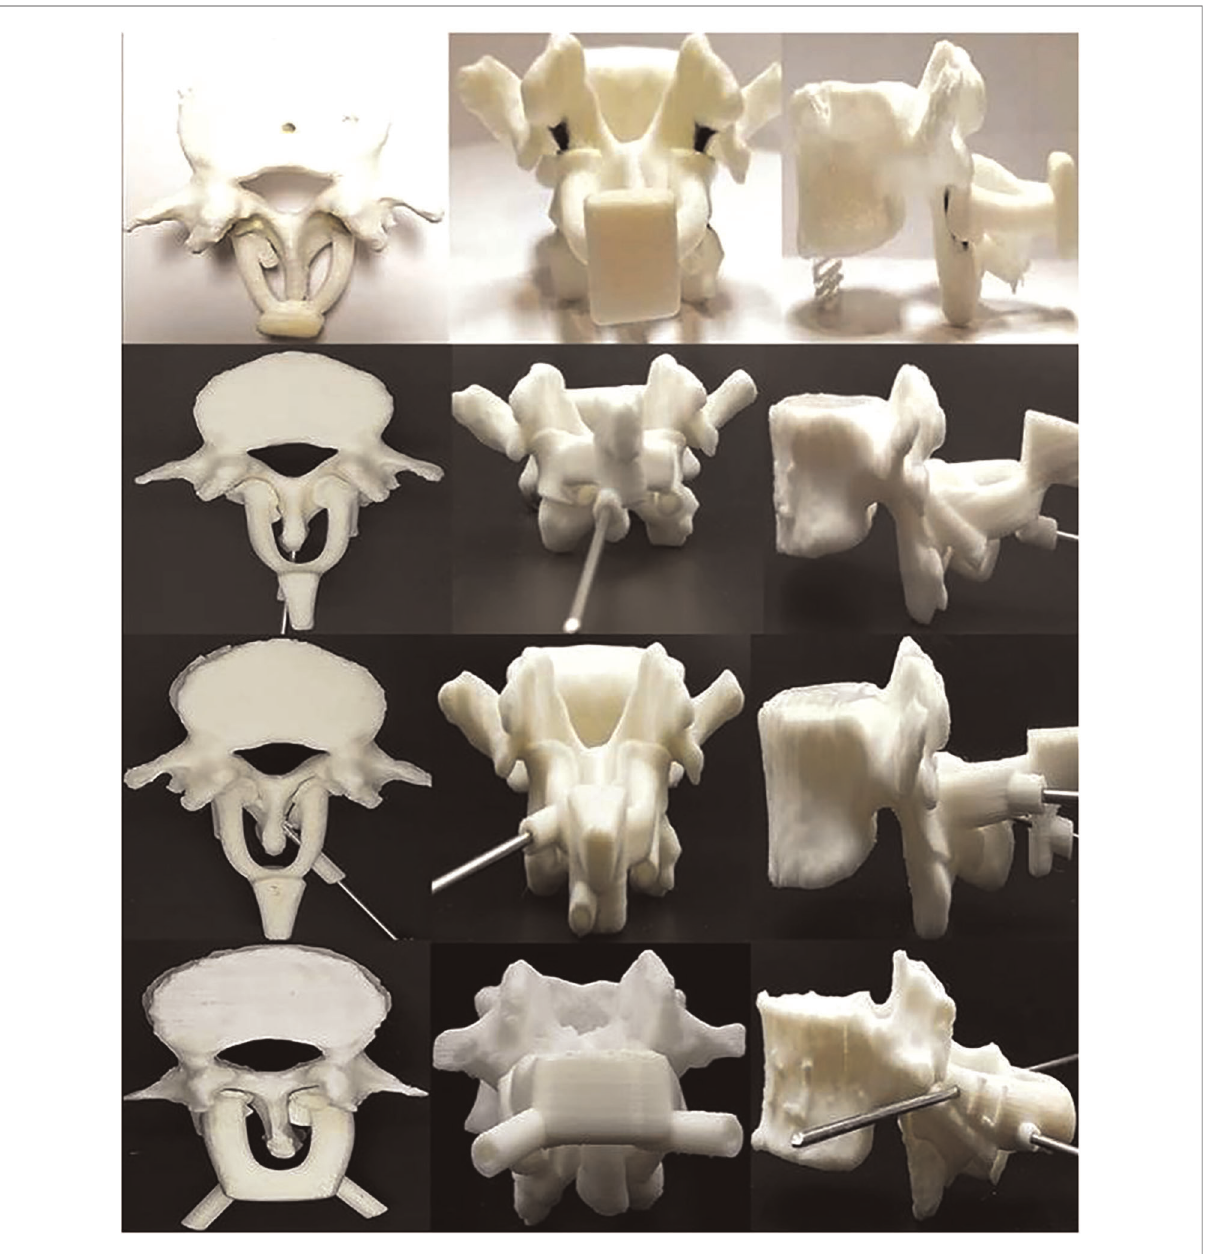
FIGURE 1 3D-printed lumbar spine specimens and four generations of navigation templates. CT scans were performed on four anatomical specimens. After reconstructing the data in 3D, each complete lumbar model was inputted into a 3D printer, and the 3D vertebral specimens were printed with anatomical specimens at a ratio of 1:1 for experimental study. During the test, we continuously optimized and upgraded the navigation templates. From the fi rst generation (top) to the fourth generation (bottom) navigation templates, the performance of the template, including adhesion, stability, convenience, safety, and other aspects, continued to